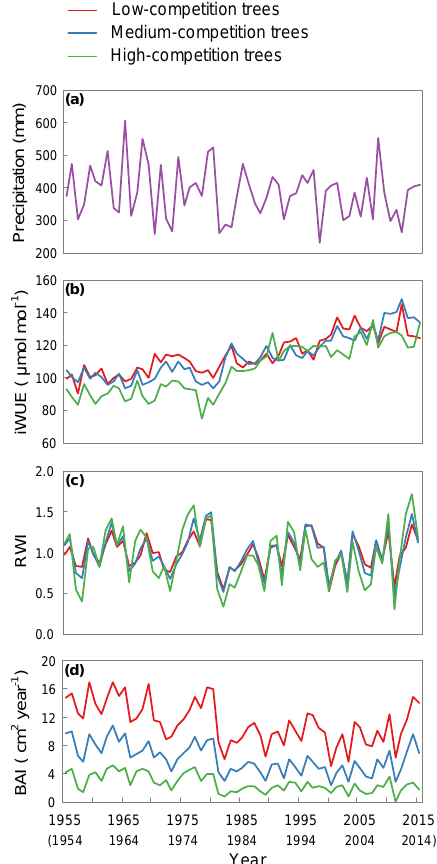
. Figure 1. Trends in ( a ) precipitation and ( b ) intrinsic water-use e ffi ciency ( iWUE ) ( n = 9) from 1954 to 2014, and the ( c ) relative width index ( RWI ) ( n = 82) and ( d ) basal area increment ( BAI ) ( n = 82) from 1955 to 2015. Raw data of iWUE and tree-ring width in this study were derived from Lu et al. (2019). Table 2. Summary of the linear mixed-e ff ects model (LMM) of the relative width index ( RWI ) as a function of precipitation and individual tree CI in 82 trees over the past 61